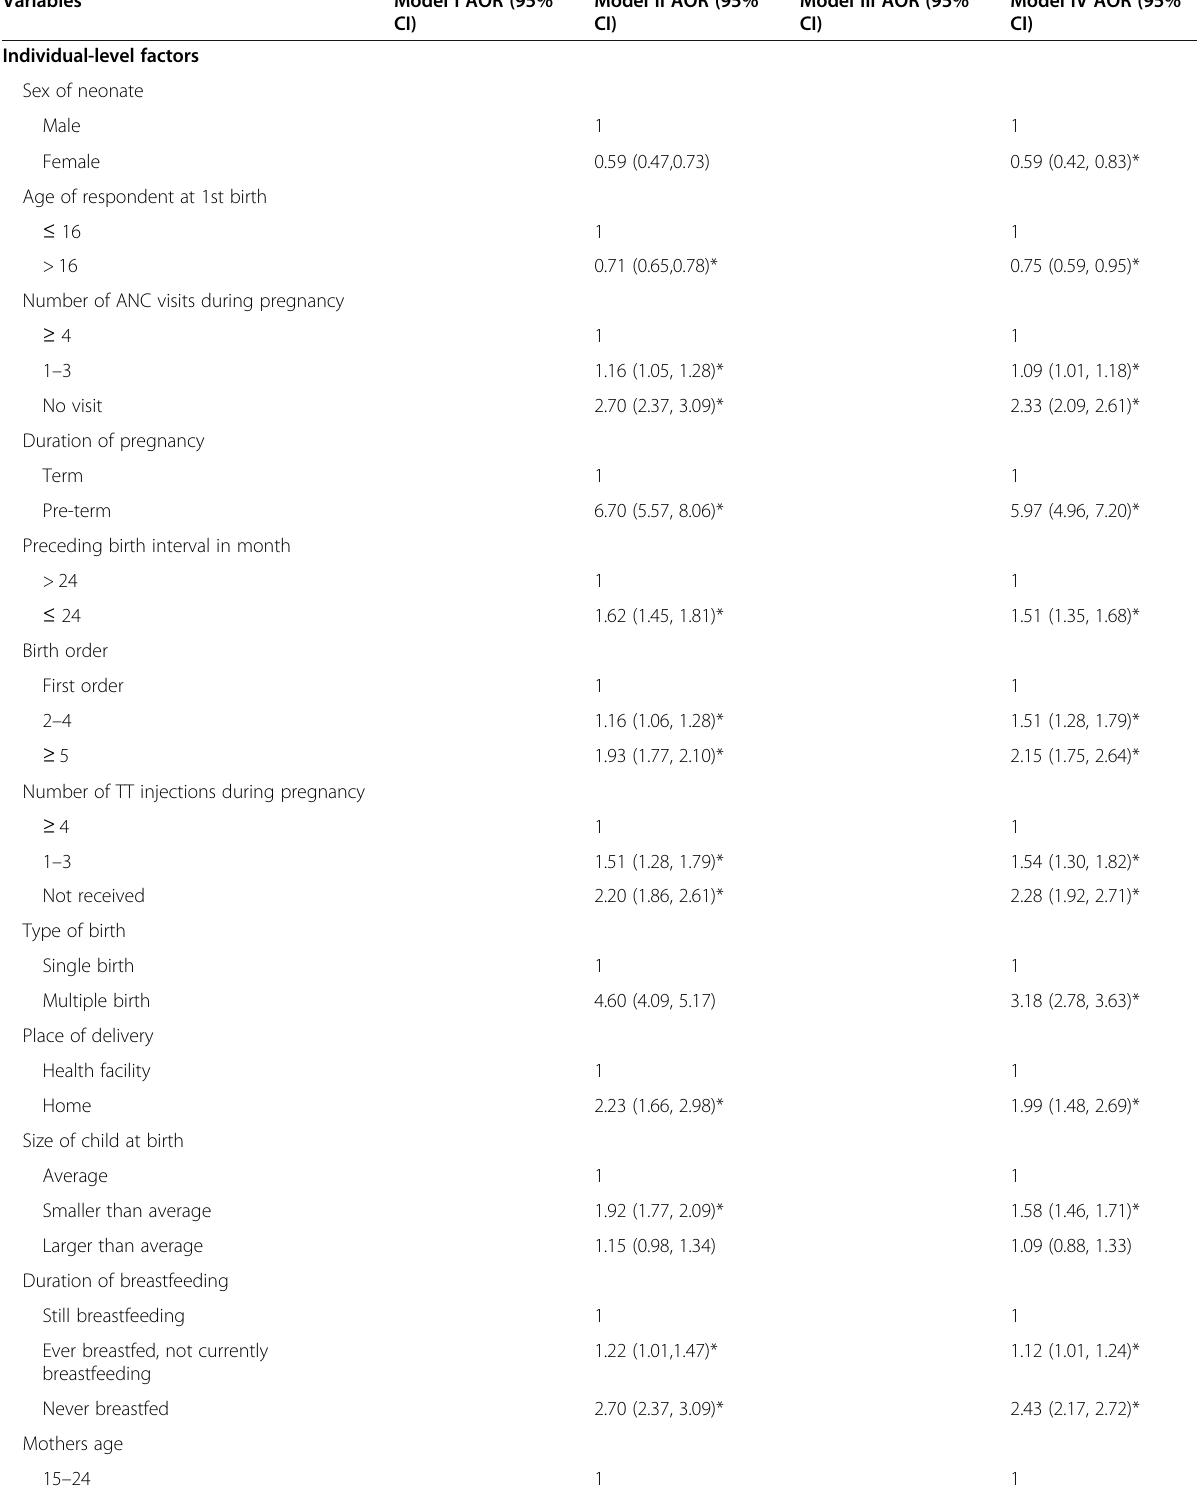
Table 3 Multilevel logistic regression analysis for risk factors of neonatal death in Ethiopia, EDHS 2016